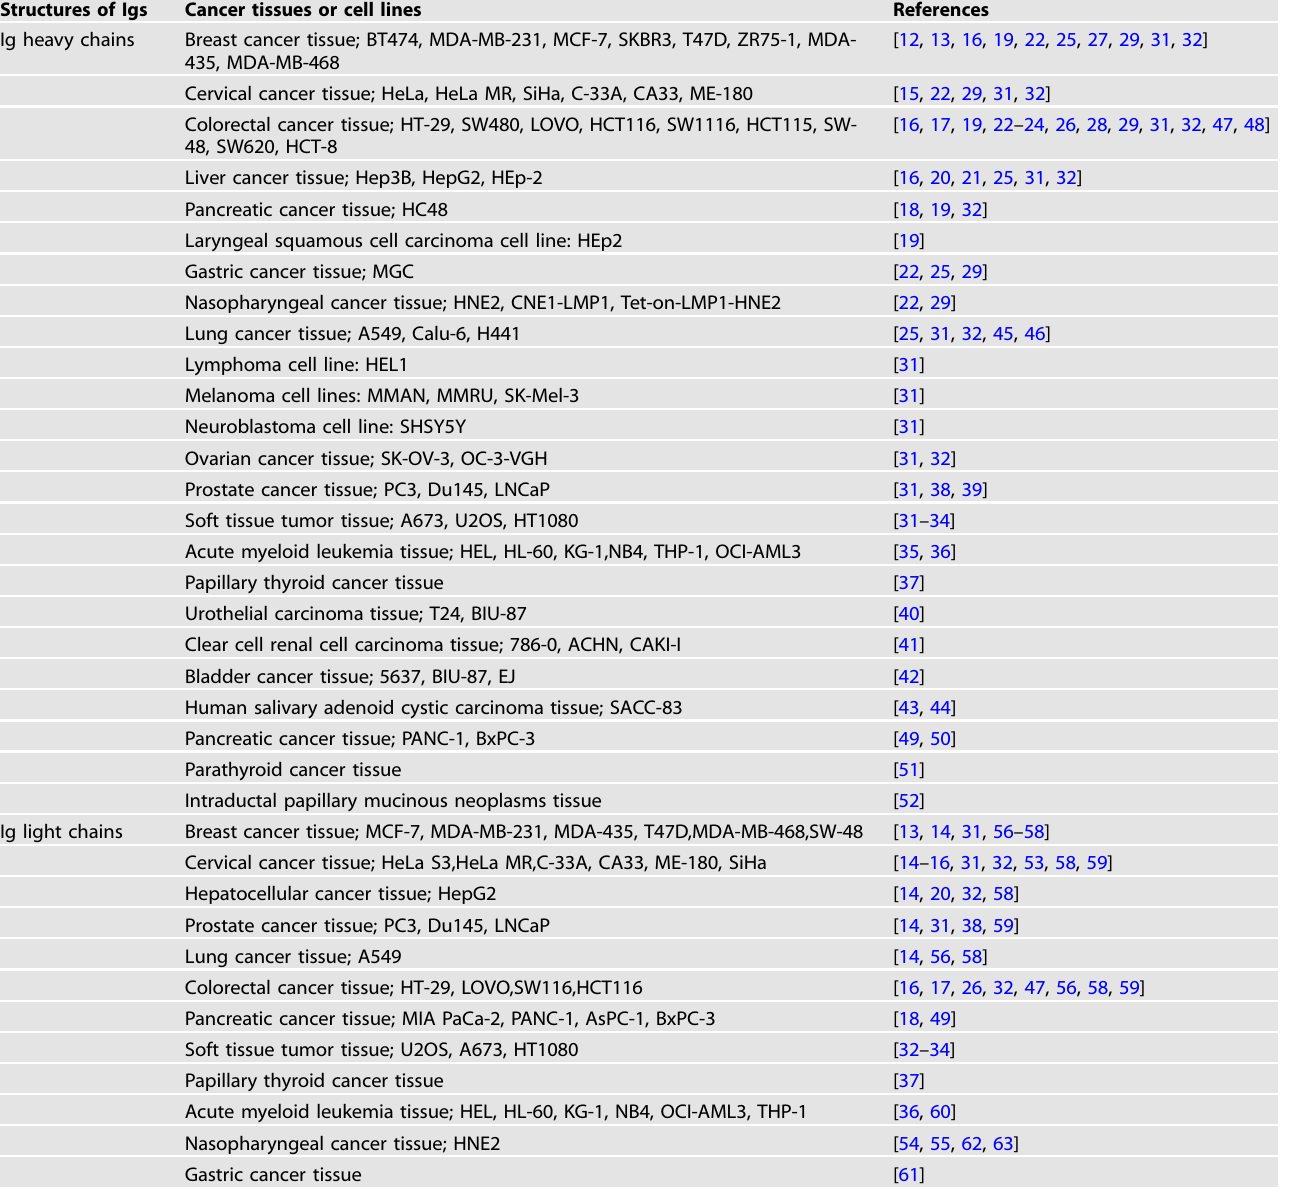
Table 1. List of tumor tissues and cell lines expressing Ig heavy chains and/or light chains. Structures of Igs Cancer tissues or cell